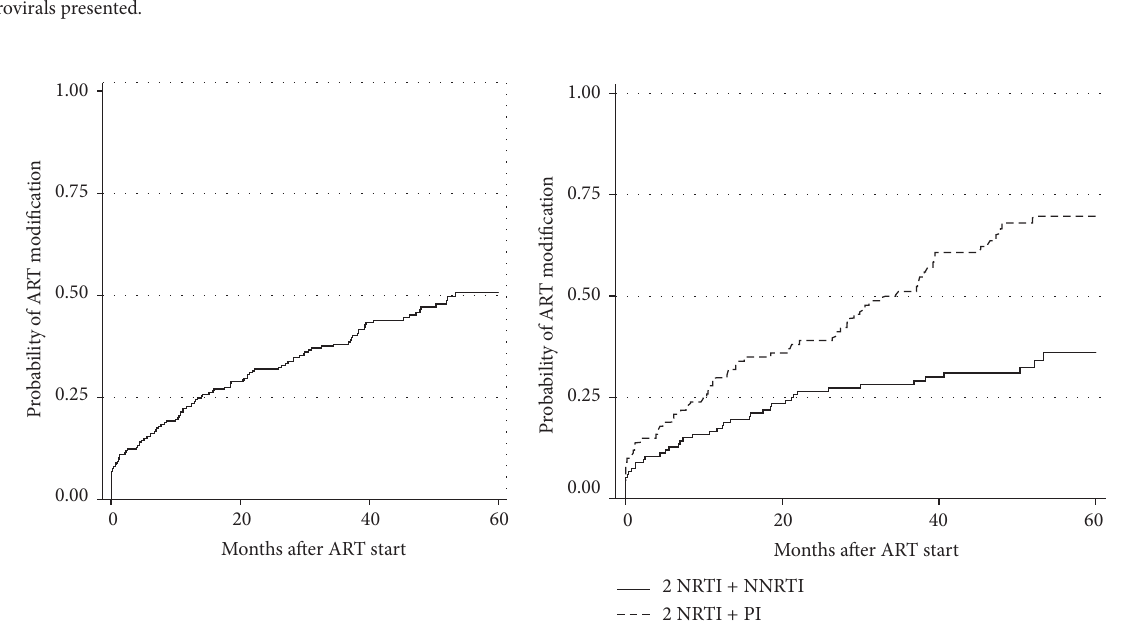
Figure 3: Kaplan-Meier failure estimations of probability of ART modification. On the left: for all 236 patients. On the right: for 236 patients stratified by ART regimen (log-rank test, 𝑝 < 0.001